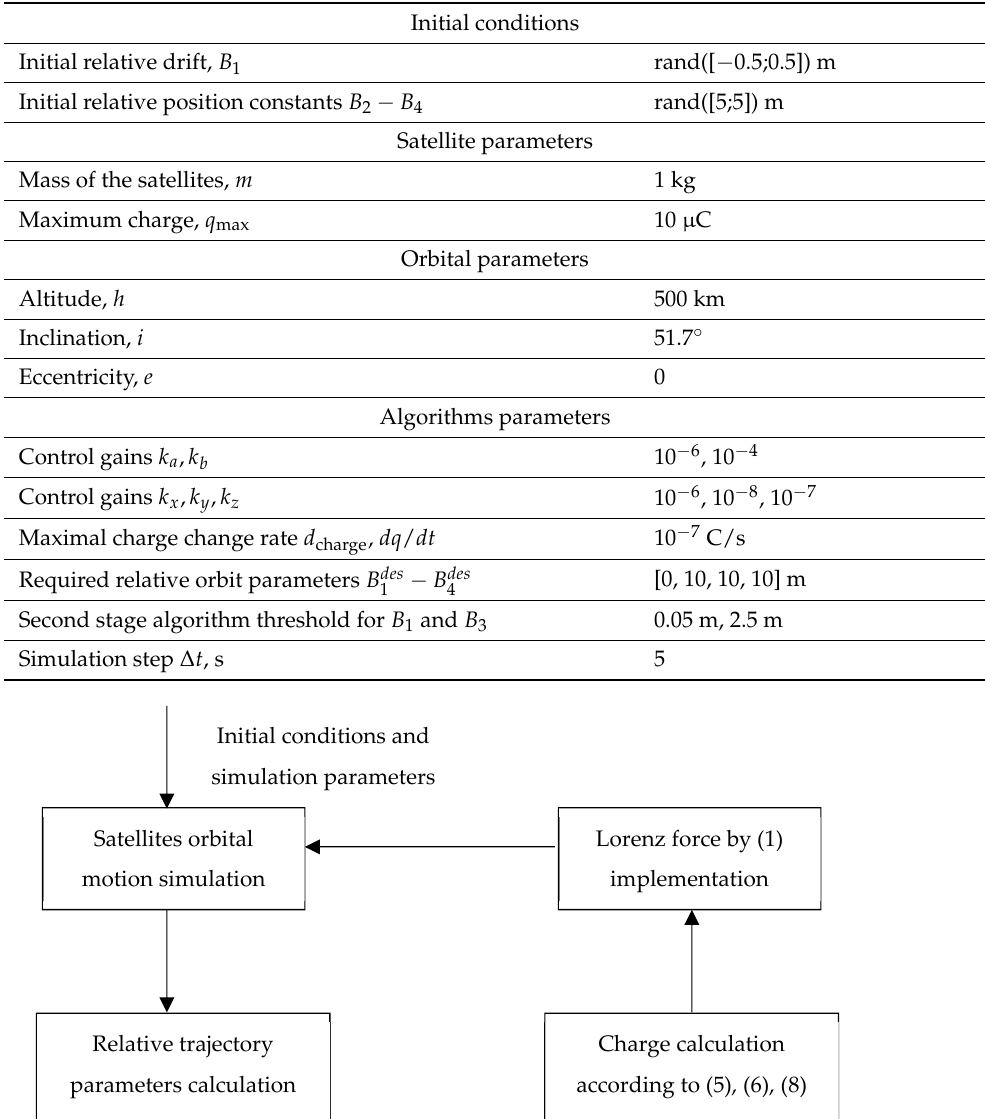
Table 1. Simulation parameters.